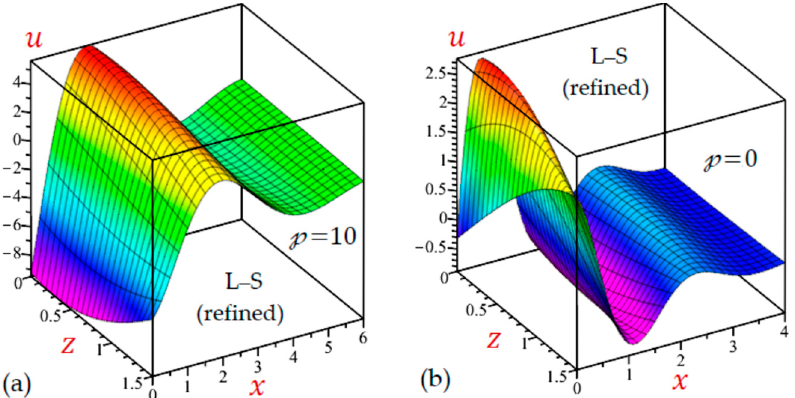
Figure 16. 3D distributions of the horizontal displacement 𝑢 of the rotating half-space: ( a ) with